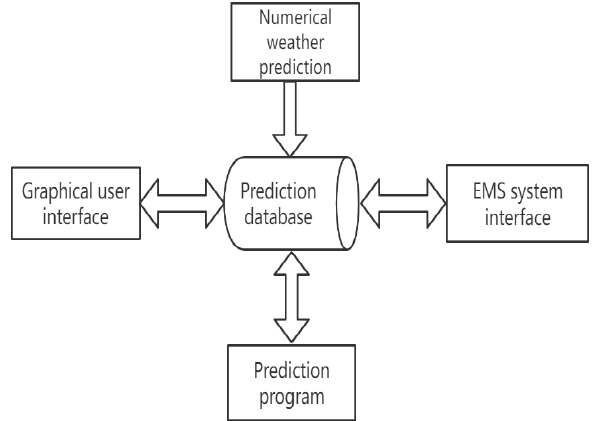
Figure 2. Prediction system